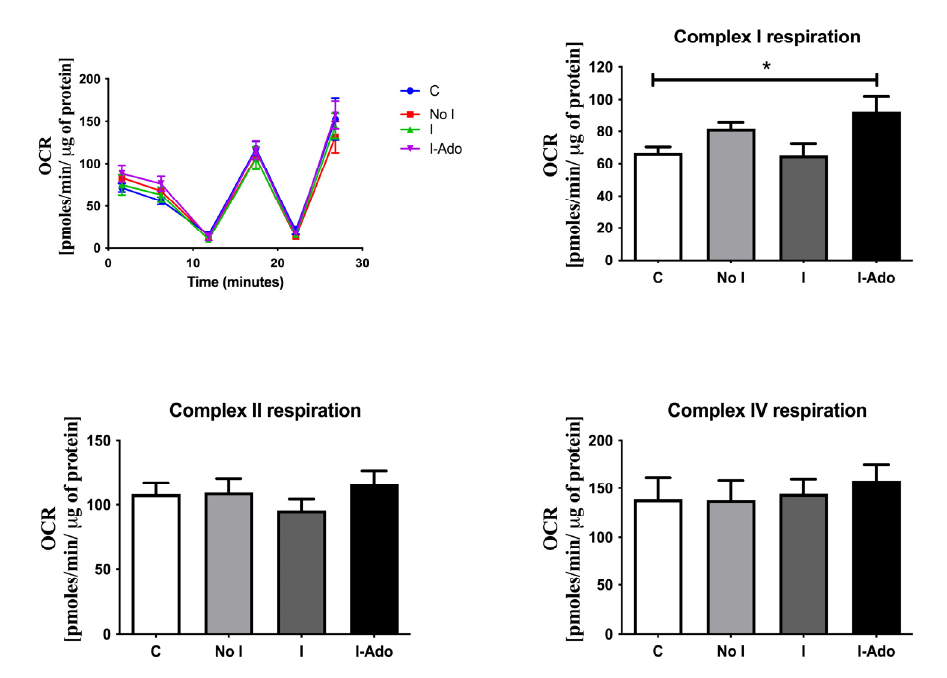
Figure 6. Oxygen consumption rate (OCR) in the mitochondria of the rat heart subjected to repeated 1 min and 10 min ischemic intervals. Values shown are initial concentrations (after a 20 min perfusion period, Group C) or at the end of protocols without 10 min ischemia (Group No I), with 10 min ischemia (Group I), and with 10 min ischemia plus infusion of 30 µ M adenosine (Group I-Ado) during reperfusion. For the initial values, the control hearts (C) were perfused for 20 min. Values are mean ± SEM ( n = 5–9). * p < 0.05 vs. concentration before 1 min ischemia. Respiration of Complex II was measured as the succinate-driven OCR. Complex I and Complex IV respiration were calculated as the resulting OCR after subtraction of rotenone or antimycin a driven respiration,